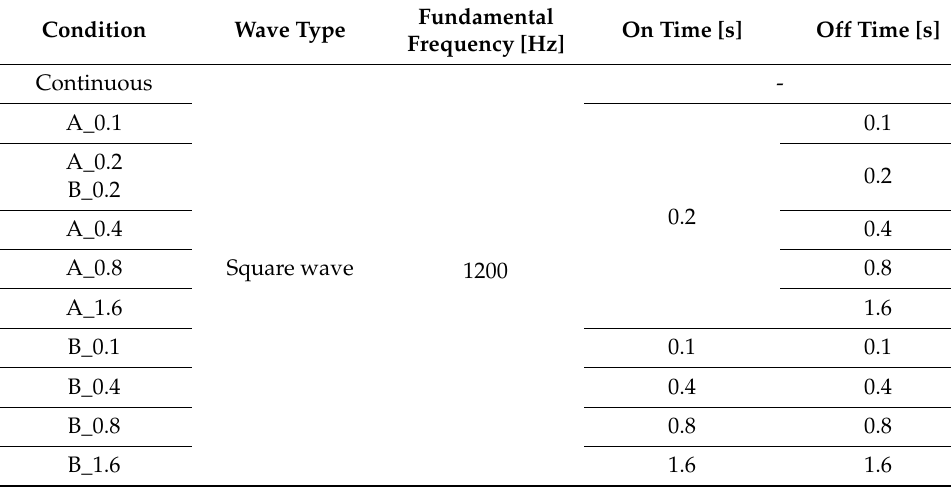
Table 5. List of warning sounds adopted for Phase 2 of the present study.